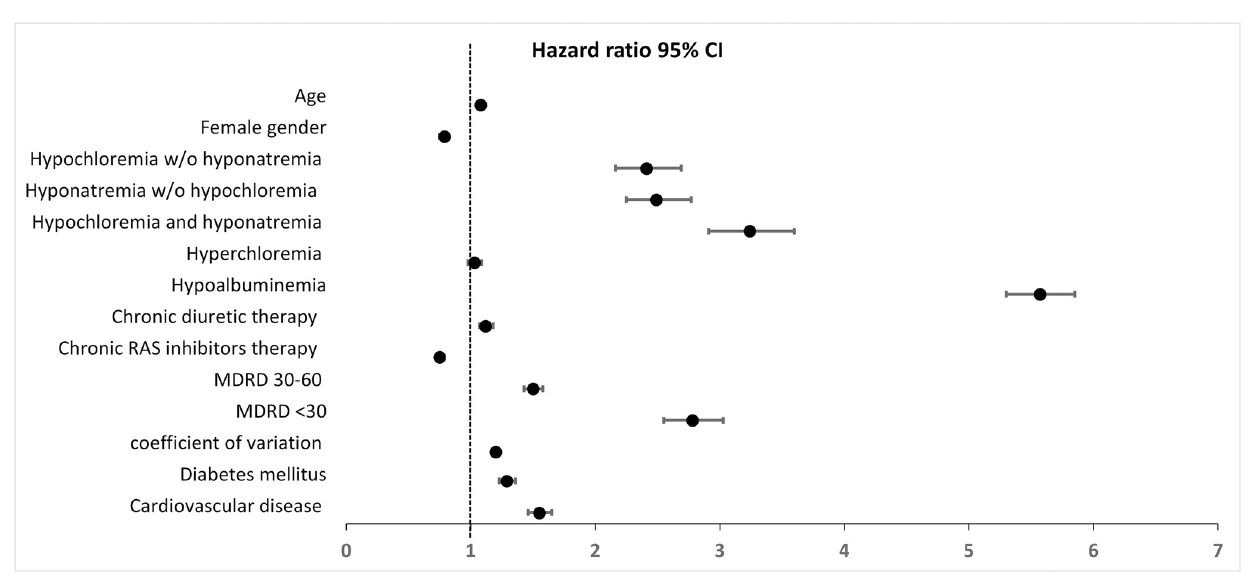
https://doi.org/10.1371/journal.pone.0279837.g002